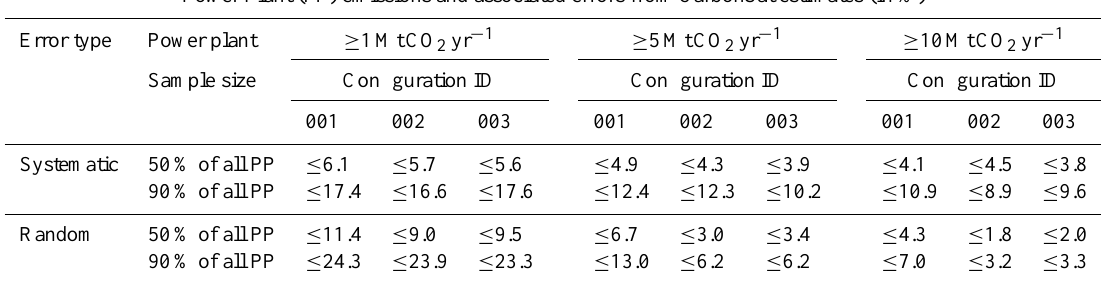
Table 2. Error estimates on annual power plant (PP) emissions from three different CarbonSat configurations. Power Plant (PP) emissions and associated errors from CarbonSat estimates (in %)